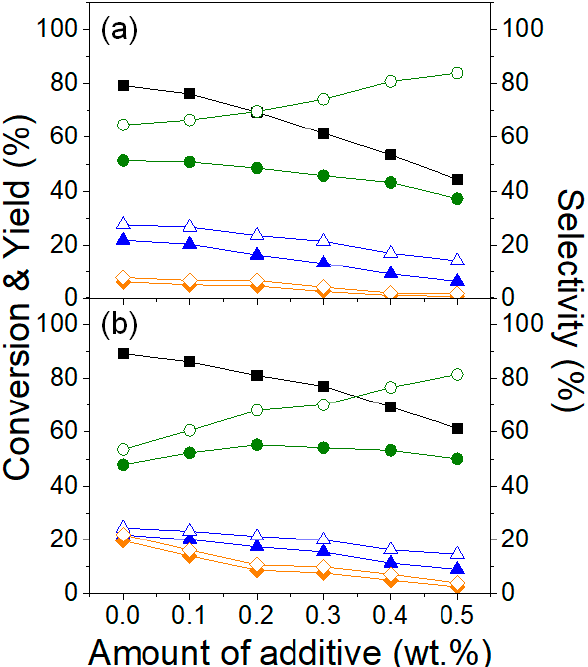
Figure 1. The influence of the amount of additive on the etherification reaction of glycerol: ( a ) Na-zeolite with NaHSO 4 and ( b ) K-zeolite with KHSO 4 (- ■ -: conversion of glycerol, - ● -: yield of DG, - ▲ -: yield of TG, - ♦ -: yield of others - ○ -: selectivity of DG, - Δ -: selectivity of TG, - ◇ -: selectivity of others, the reaction temperature: 280 °C, the reaction time: 2 h).